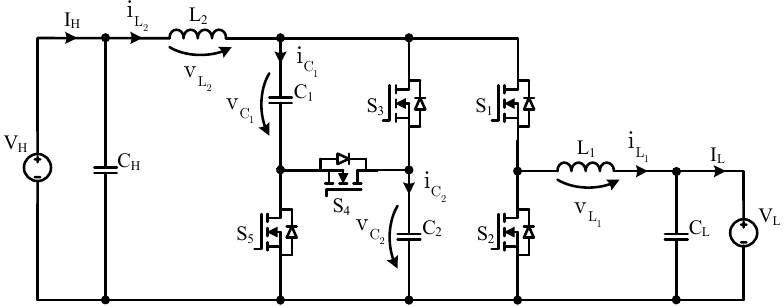
Figure 2. The bidirectional hybrid switched-capacitor (BHSC) converter.